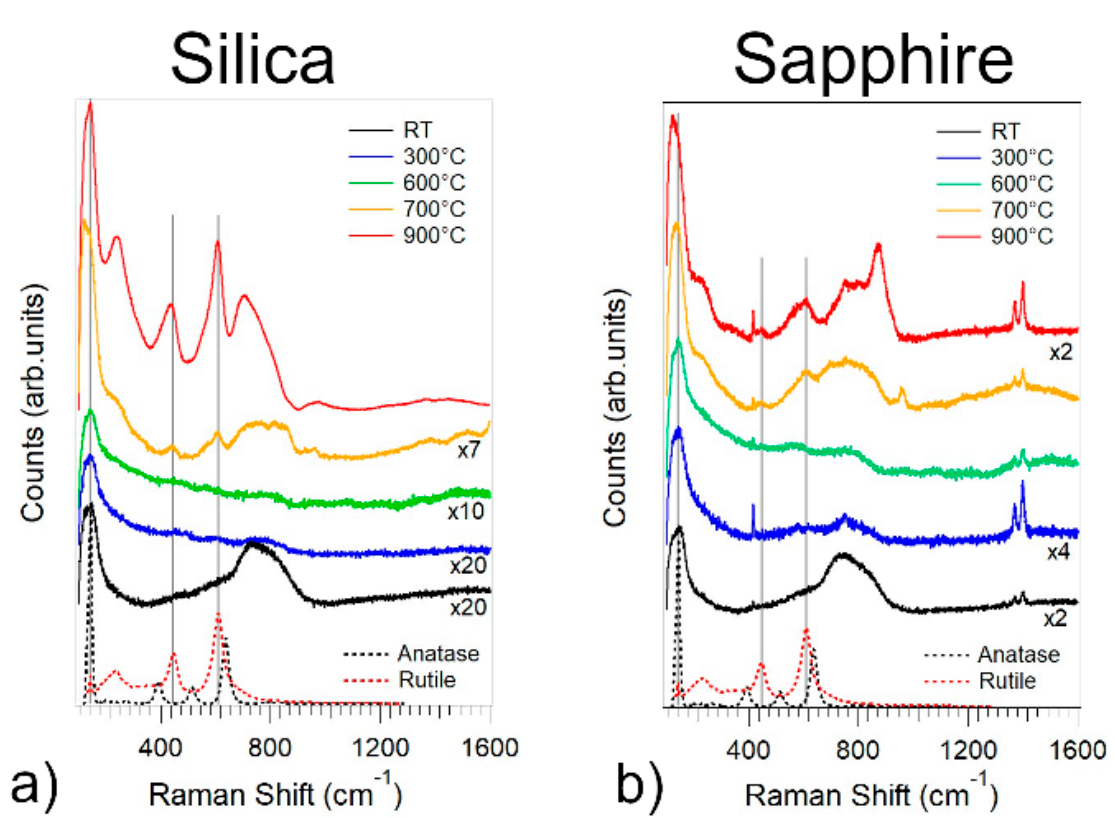
Figure 5 . Raman spectra of the Ag/TiO 2 film on silica ( a ) and sapphire ( b ) as a function of the annealing temperature, respectively. The dotted lines represent the Raman spectra of anatase (red) and rutile (black).